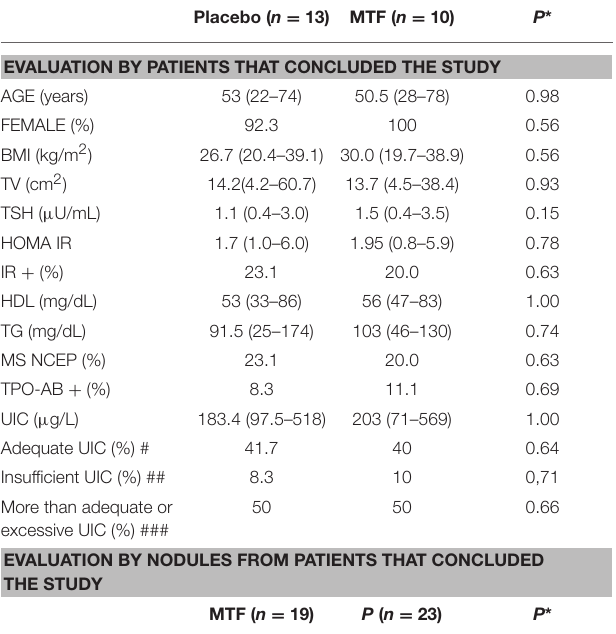
TABLE 1 | Baseline characteristics of interesting variables between the studied